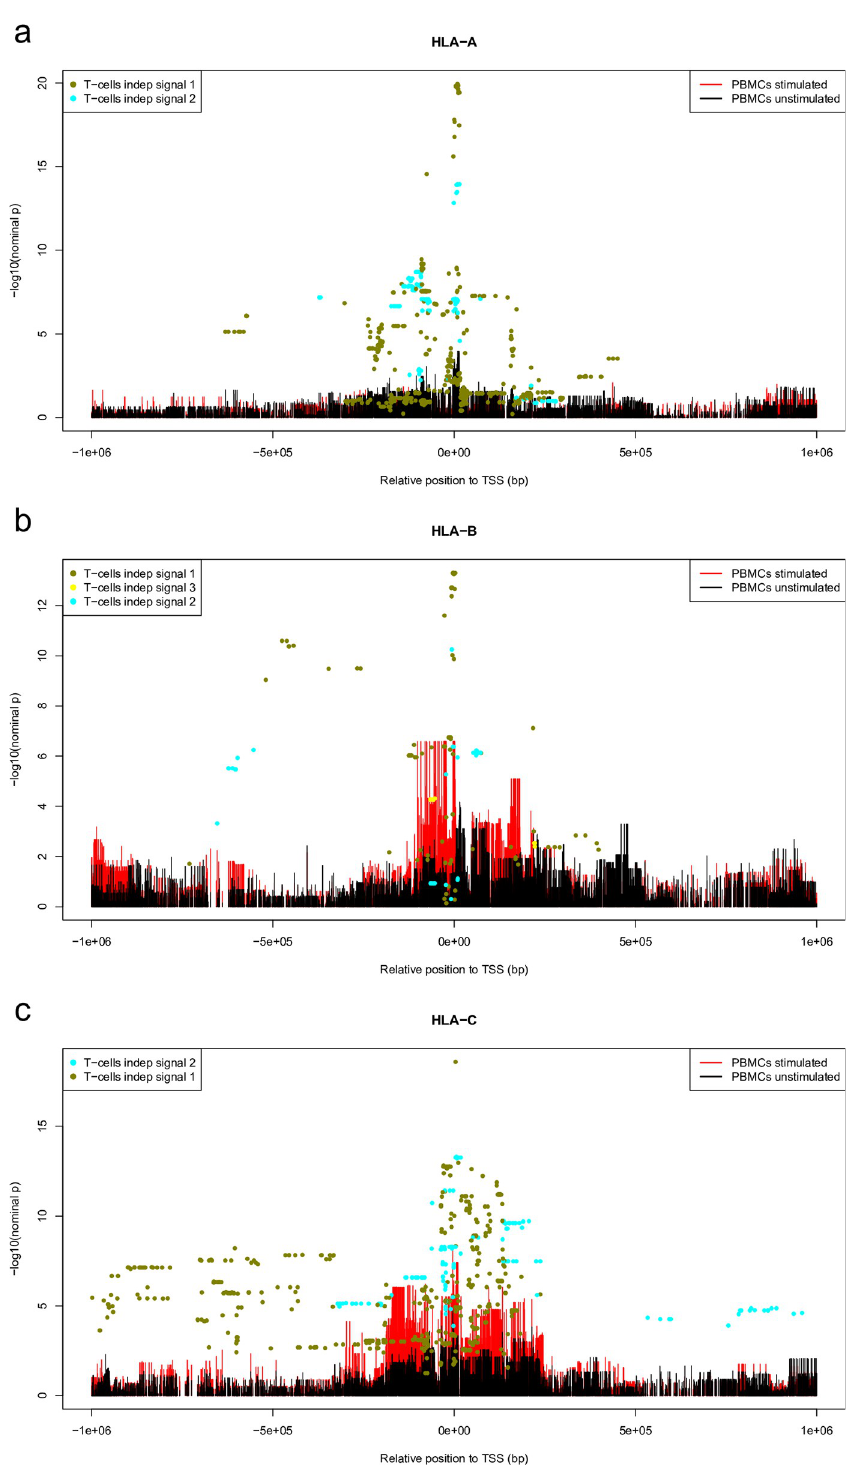
Fig 5. The genomic locations of the eQTLs. The genomic locations of the eQTL associations in the cis regions ( ± 1 Mb from the transcription start site) of HLA-A ( a ), HLA-B ( b ), and HLA-C ( c ). The x-axes are the relative position of the variants to the TSS, and the y-axes represent the significance of the eQTL association (-log10 nominal p-value). The colored bars show all the variants in the region and their eQTL p-values in stimulated and unstimulated PBMC cells. The colored points represent all the variants for each of the genome-wide significant independent eQTL signals in Blueprint T cells.